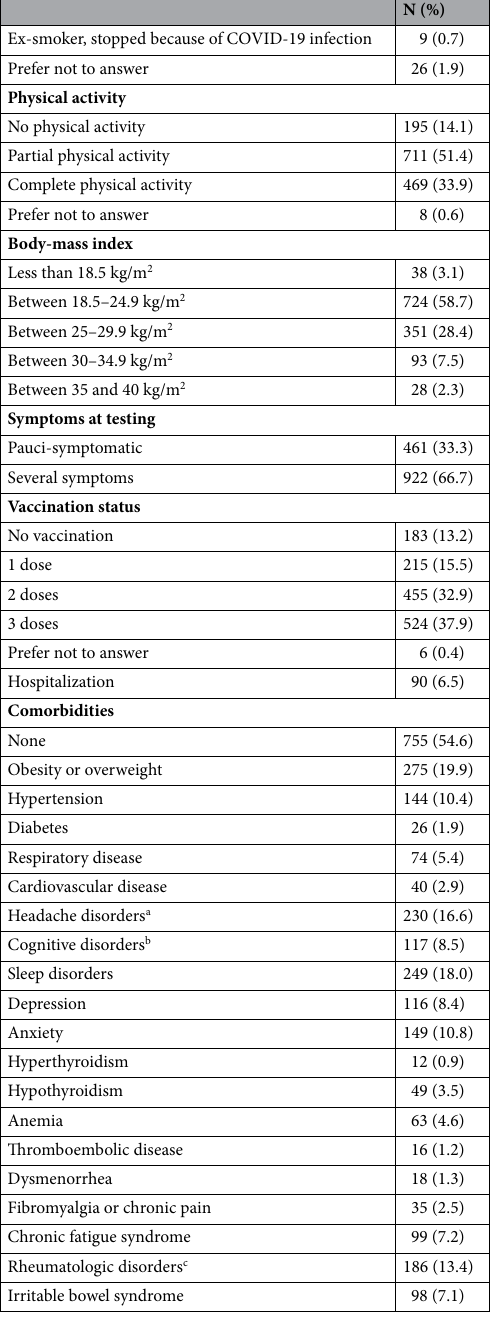
Table 1. Baseline characteristics of participants (n = 1383). a Headache disorders include migraine, tension headaches, and other types of headaches. b Cognitive disorders include memory and attention deficit. c Rheumatologic disorders include tendinitis, polymyalgia rheumatica, arthritis, and ankylosing